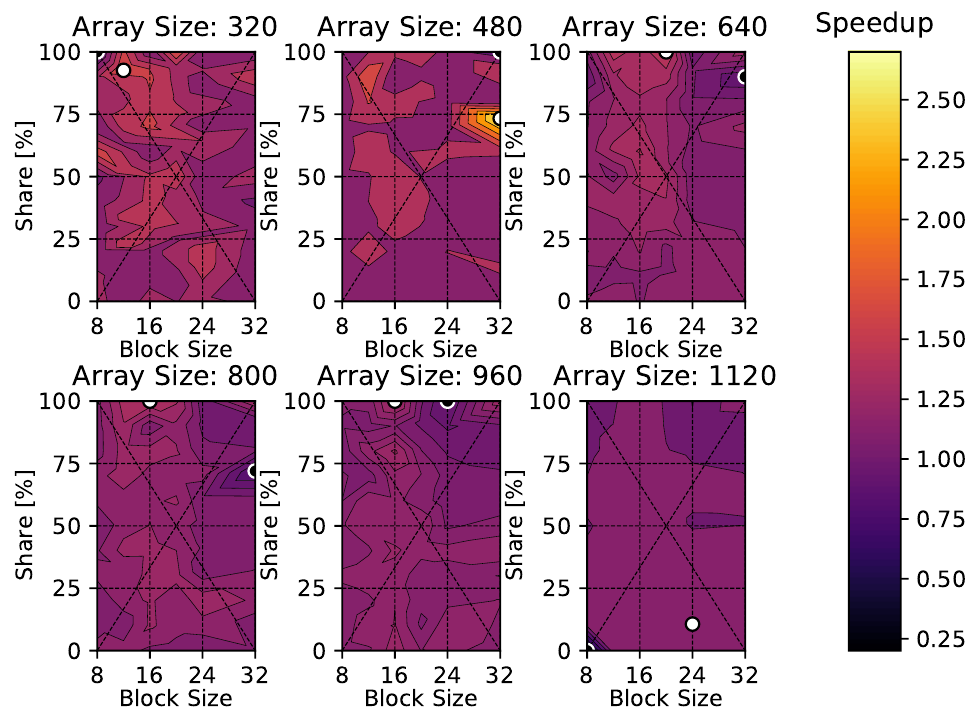
Figure 5. Swept rule speedup results for the heat equation with Tesla V100-DGXS-32GB GPUs and Intel E5-2698v4